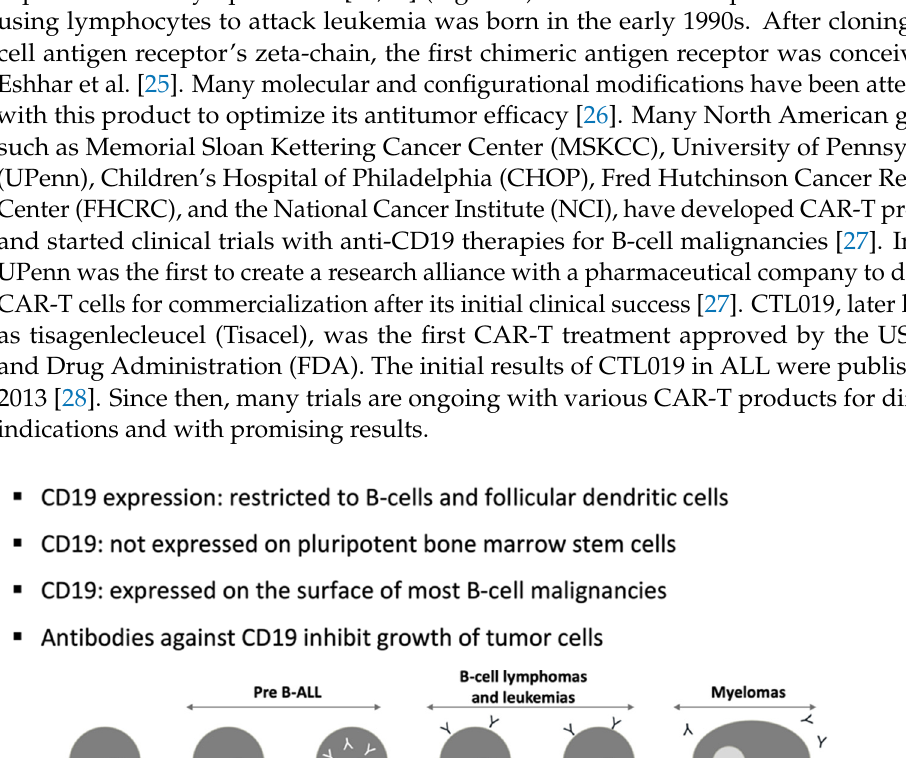
Table 1. CAR T-cell targets for the treatment of B acute lymphoblastic leukemia (ALL).